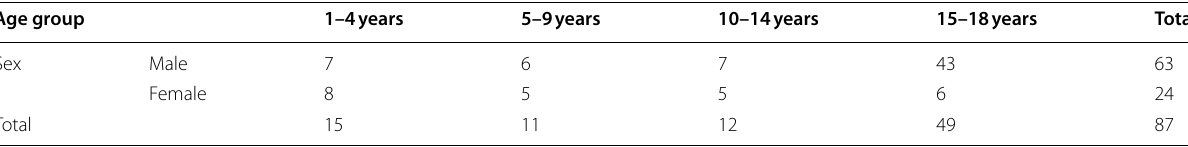
Table 1 Distribution of cases by sex and age group Age group